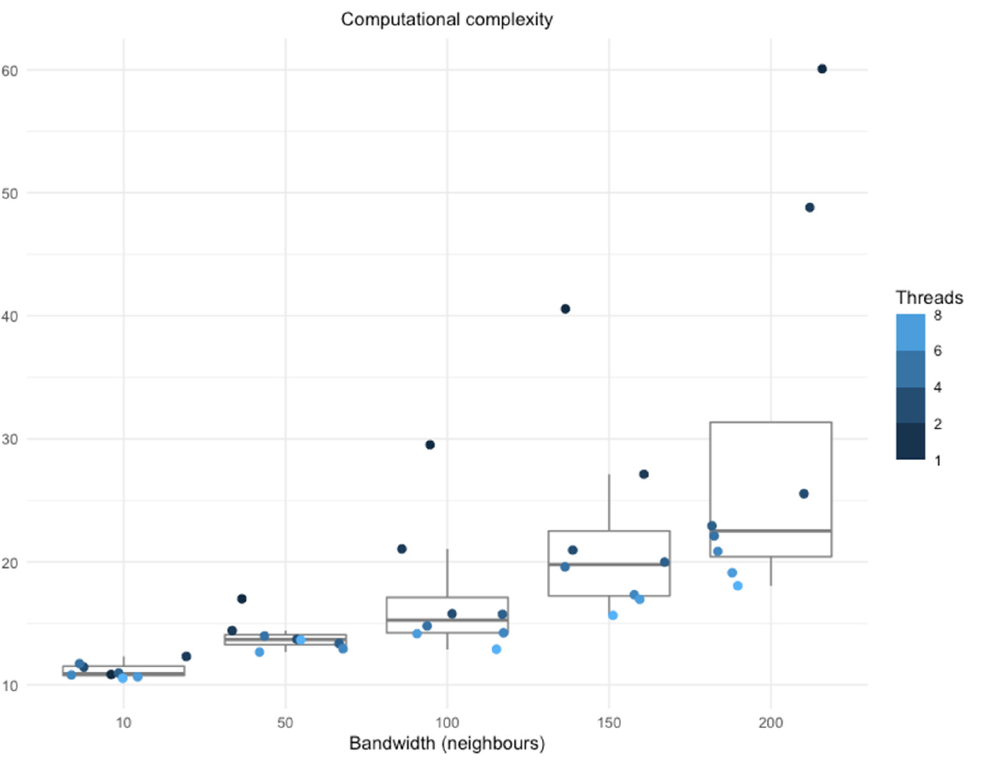
Figure 4. The computational effect of parallelization with multiple threads in training GRF models with multiple bandwidths.